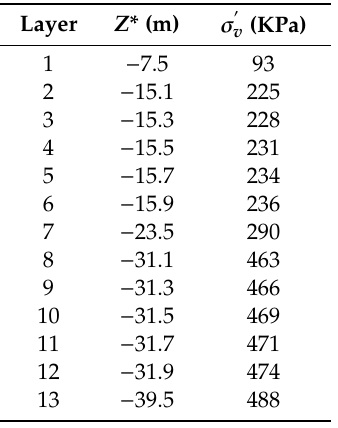
Table 2. Geostatic properties of the model.